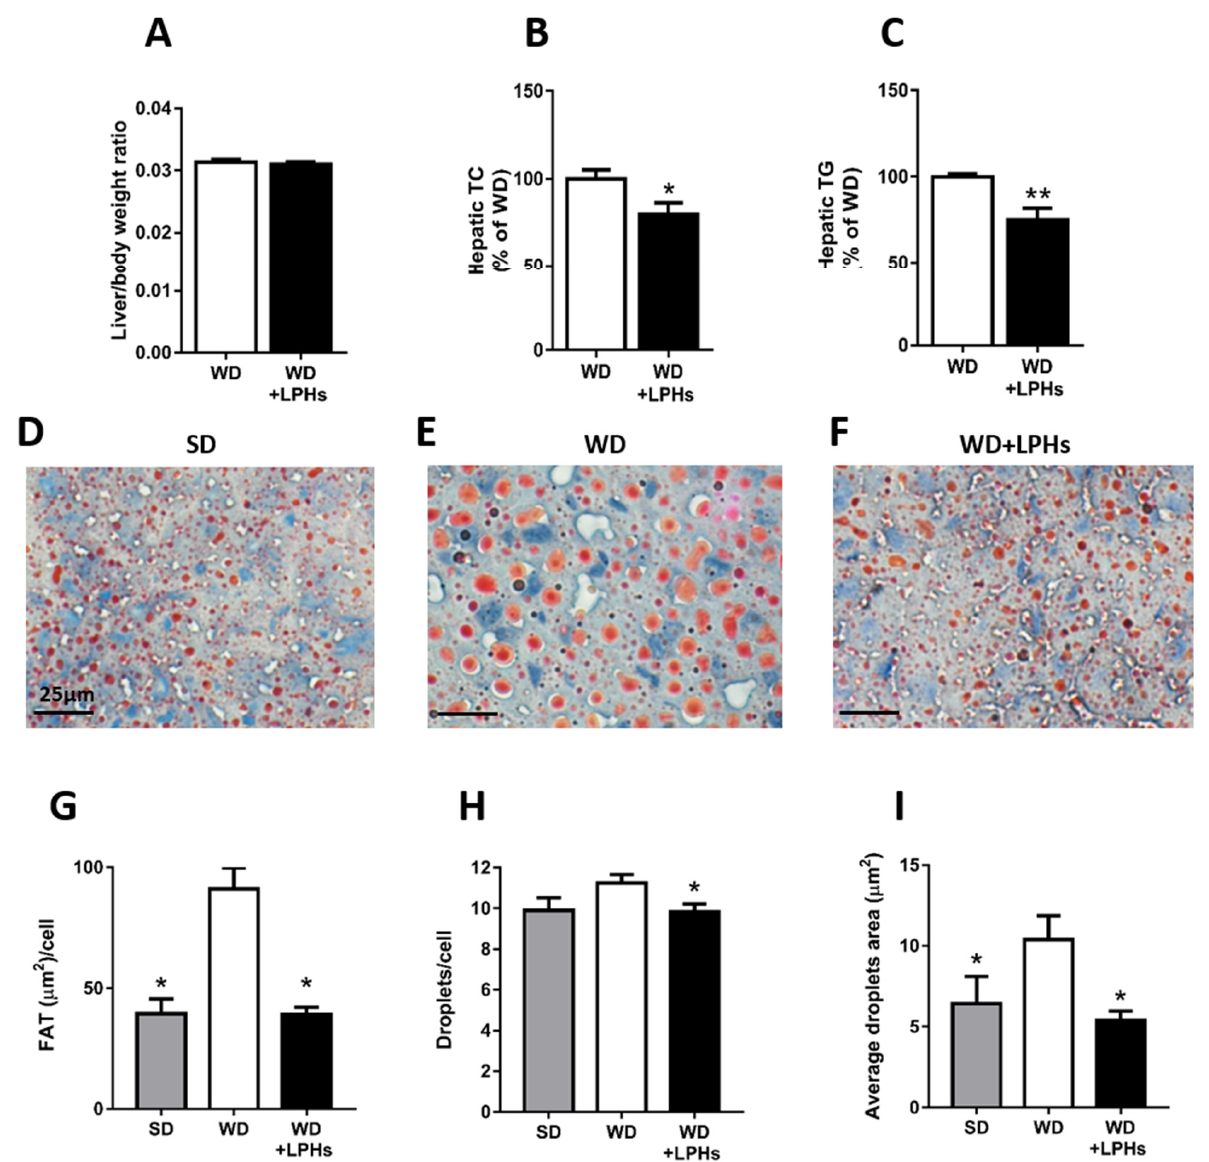
Figure 3. Hepatic lipid profile . Liver/body weight ratio ( A ) ( n = 30). hTC ( B ) and hTG ( C ) content of both experimental groups ( n = 15). Representative images of Oil red O staining of liver tissue from SD ( D ), WD ( E ), and WD+LPHs ( F ) groups. Quantitative analysis of fat area ( G ), droplets/cell ( H ), and average droplets area ( I ). Values are shown as the mean and the standard error of the mean of each group. * p ≤ 0.05 with respect to the WD group. ** p ≤ 0.01 with respect to the WD group. SD, standard diet group; TC, total cholesterol; TG, triglycerides; WD, western diet group; WD+LPHs, western diet + lupin protein hydrolysates group .